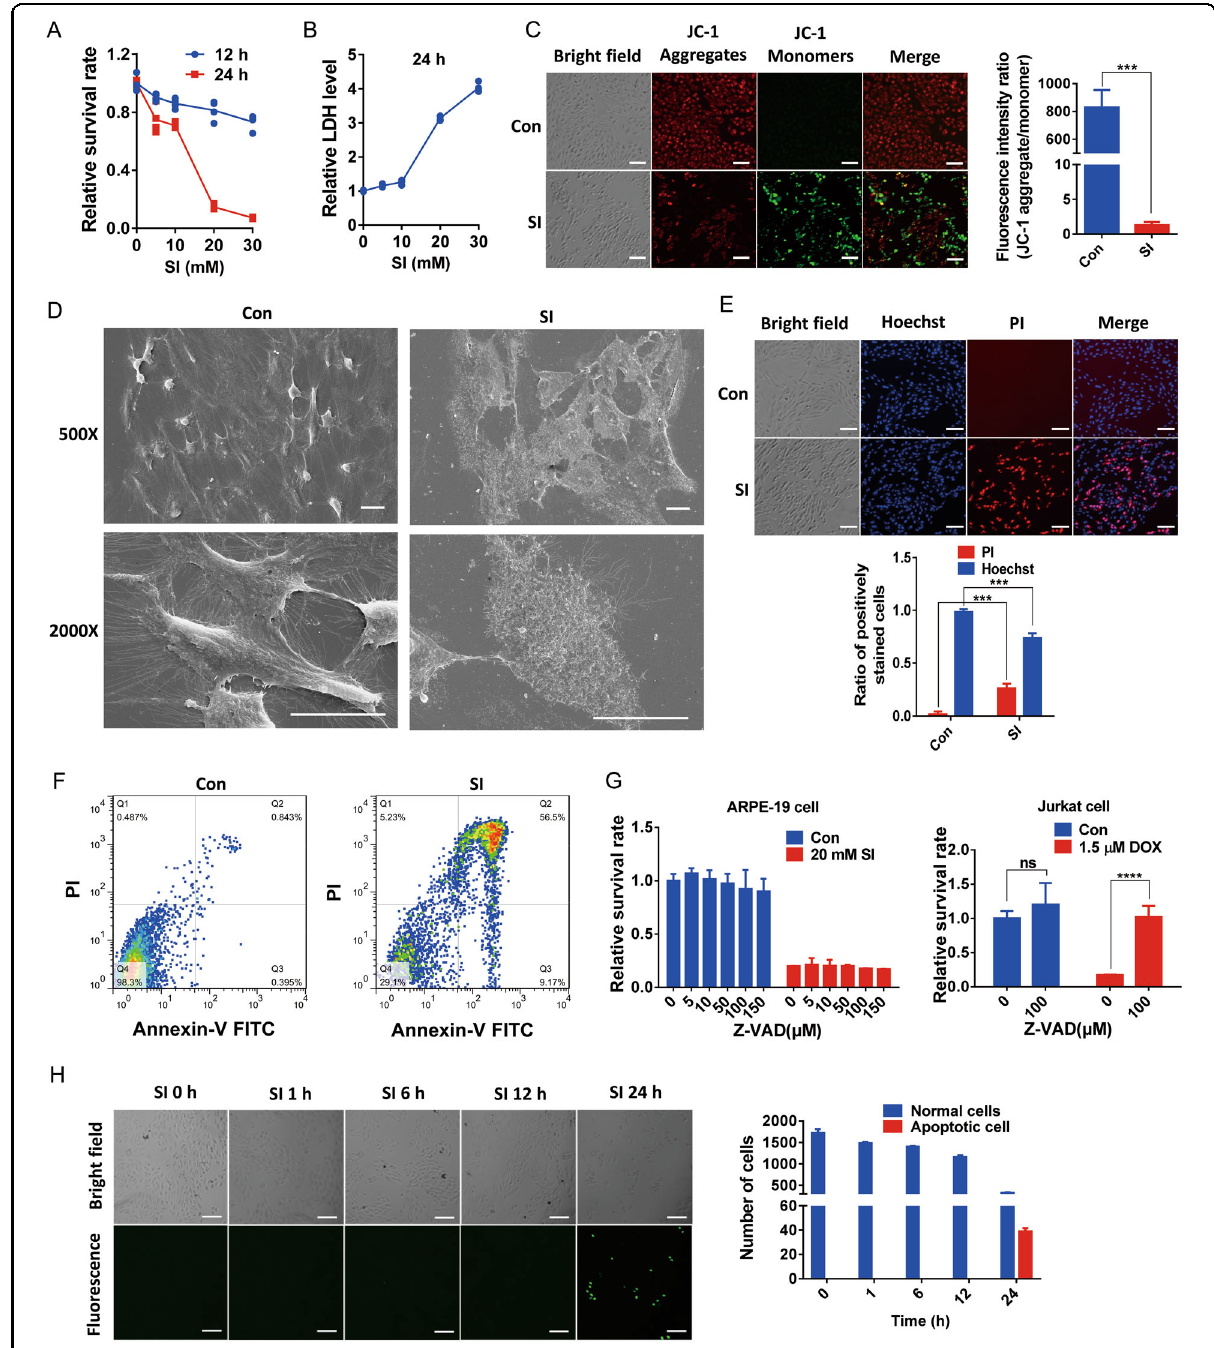
Fig. 1 (See legend on next